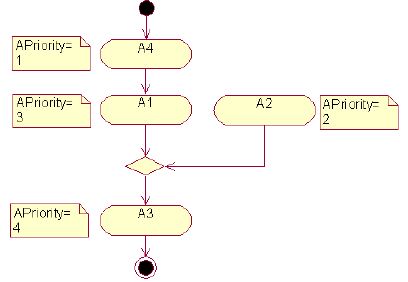
Fig. 7. Assigning APriority tag value for an activity diagram with decision